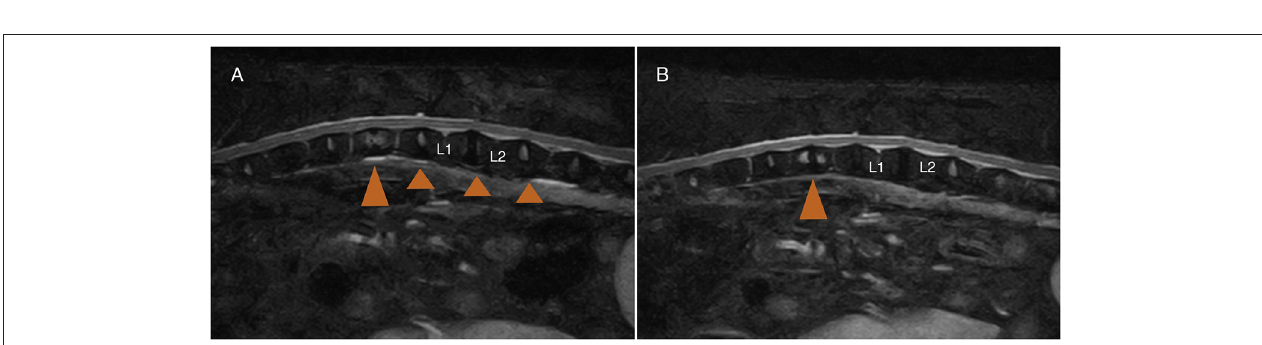
FIGURE 2 | Midline (A) and 4mm from midline (B) MRI-1 short-tau inversion recovery (STIR) sagittal images of a dog that developed discospondylitis post-operatively, 4 months following dorsal laminectomy and IVD annulectomy. The diagnosis was based on the combination of severe and progressive clinical signs, lack of significant persistent IVD protrusion causing neural tissue compression and changes affecting the epidural space (arrow-head) and the vertebral body (arrow), and erosion of the end plates.